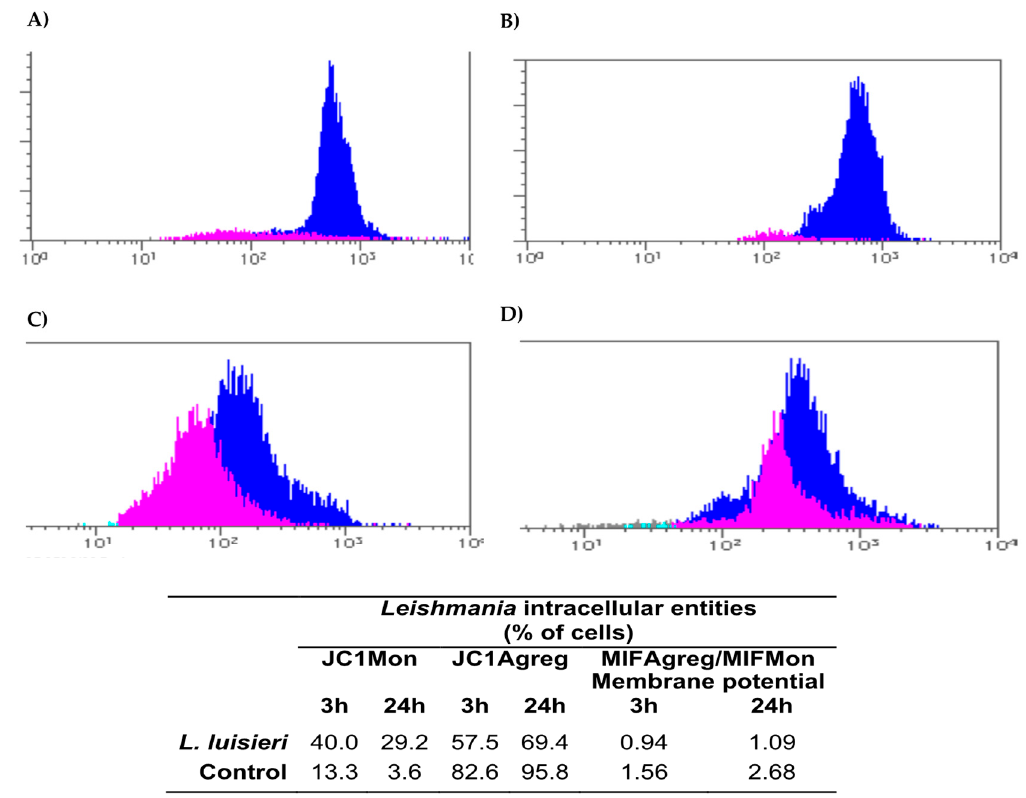
Figure 4. Representative dot plots showing JC-1 staining of Leishmania infantum promastigotes exposed to Lavandula luisieri essential oil. L. infantum promastigotas were incubated at 26 ◦ C for 24 h in the absence (( A ) 3 h; ( B ) 24 h) or presence of L. luisieri essential oil (( C ) 3 h; ( D ) 24 h) at IC 50 concentrations. JC-1 staining was performed and samples were analyzed by flow cytometry. J-aggregates (blue) reflect functioning mitochondria and monomers are indicative of compromised mitochondria (pink).